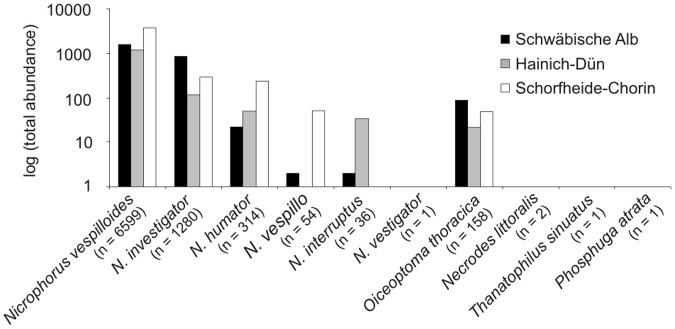
Total abundance of individuals of each trapped silphid beetle species.Y-axis is shown in logarithmic scale. Abundance data are separated for each exploratory. Exposure of 61 piglet cadavers from August 4th until September 4th 2014 (N. = Nicrophorus).